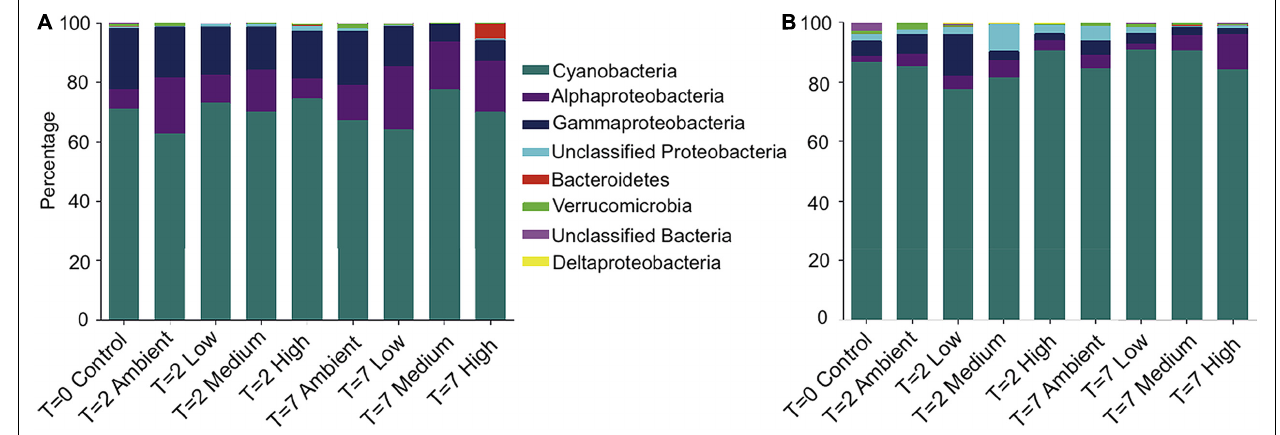
FIGURE 2 | Relative abundance of each bacterial phyla, plus class for Proteobacteria , within each treatment for (A) DNA-derived and (B) RNA-derived sequences. The three replicate individuals per treatment were averaged. For clarity, only the 50 most abundant operational taxonomic units (OTUs) were used to create the